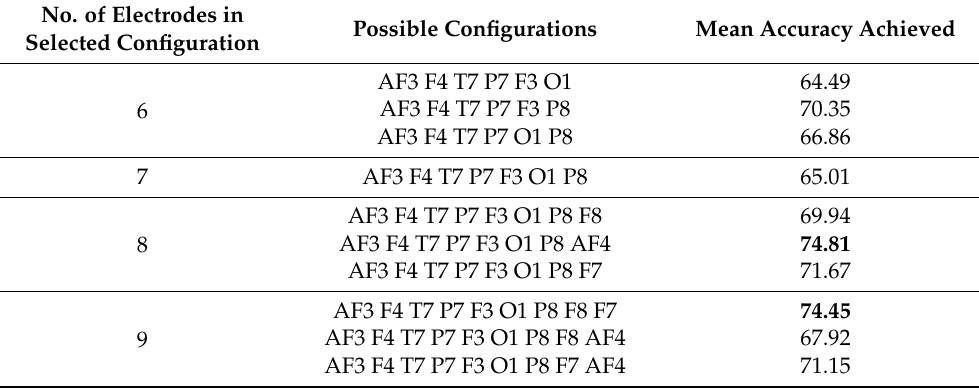
Table 5. Mean accuracies over varying number of electroencephalography (EEG) channels.